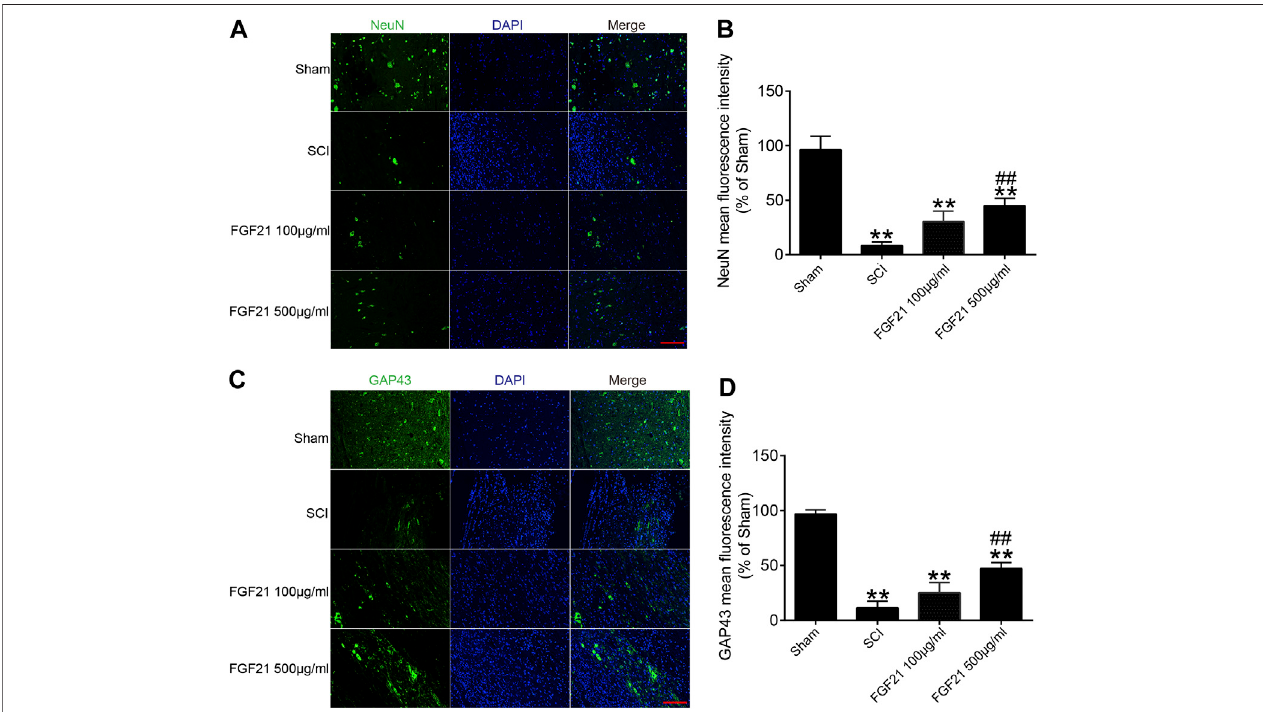
FIGURE 4 | FGF21 treatment increases the expression of NeuN and GAP43 (A,C) Image of Immuno fl uorescence staining of NeuN and GAP43 in spinal cord lesions for each group. The bright green dots are positively stained neurons marked with obvious NeuN and GAP43; respectively. DAPI (blue) is applied to mark